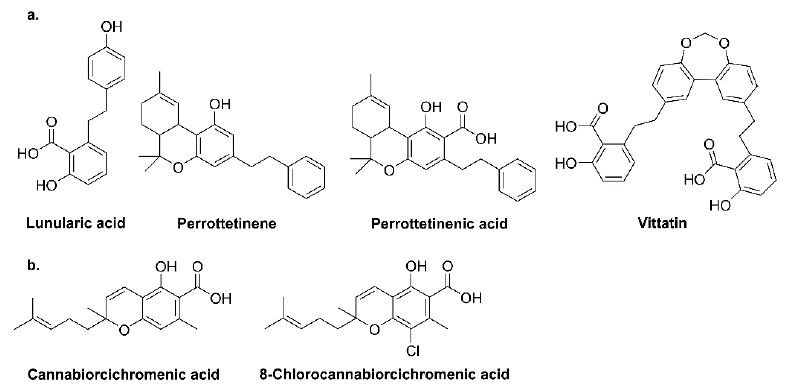
Figure 4. Structure of phytocannabinoids in ( a ) liverworts and ( b ) fungi.